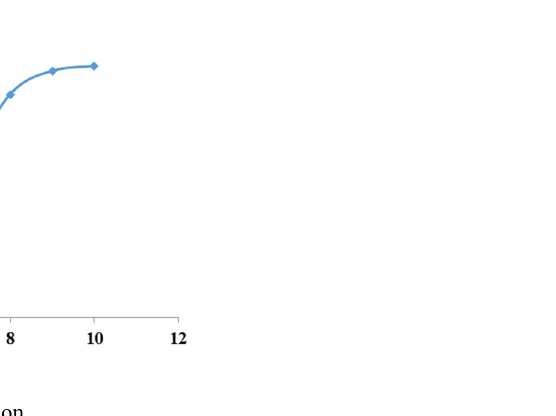
Figure 12. The effect of pH on MB